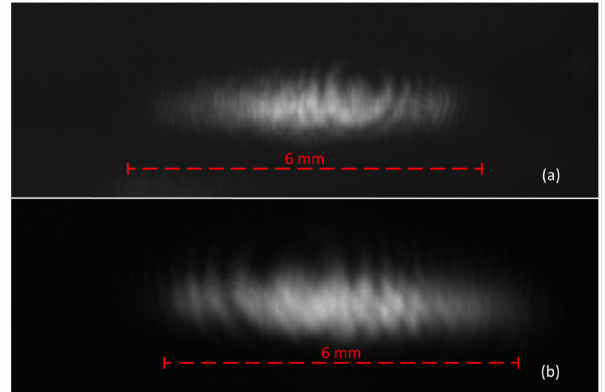
Figure 10. Laser beam profile measurements of the beam. ( a ) After reflection at the MAAM mirror (membrane voltage 0 V). ( b ) After 600 mm of free space propagation without MAAM. Both images are normalized to an image gray value of 200 for measured peak